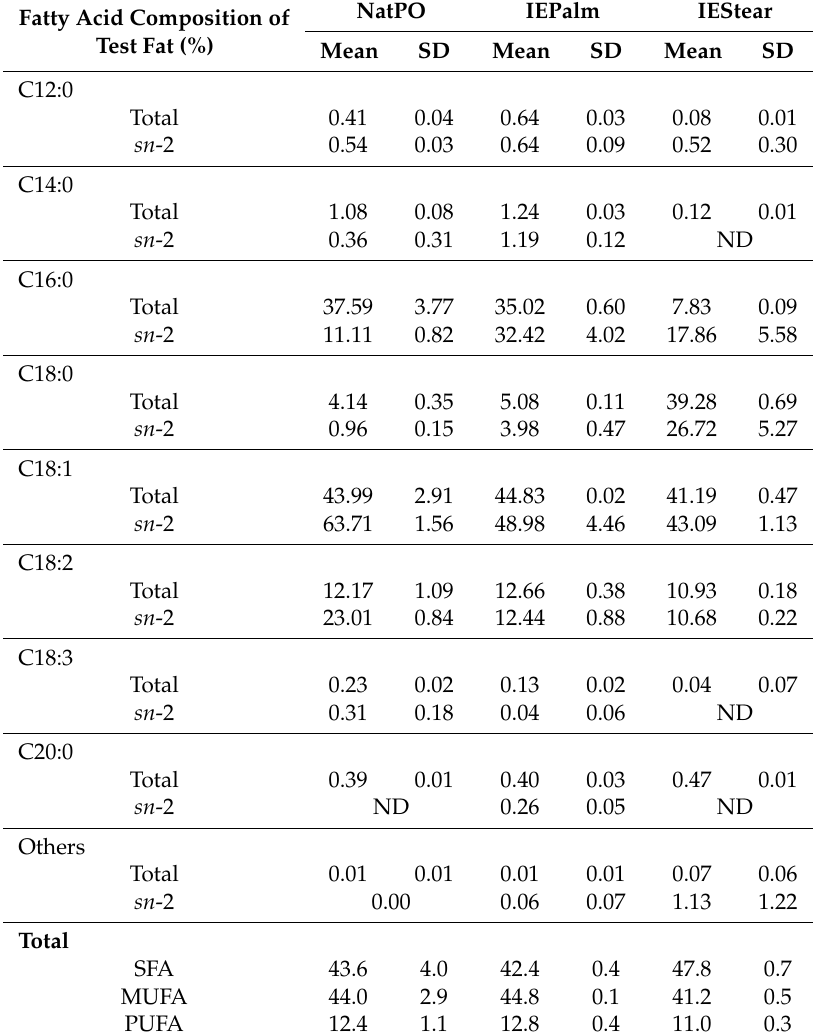
Table 1. Fatty acid compositions of the three test